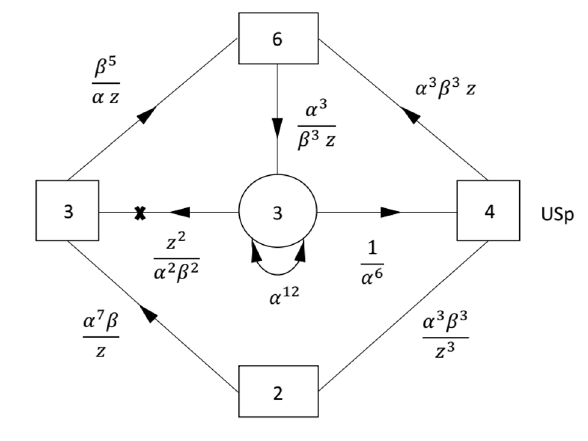
Figure 17 . The tube we get by gluing the tube in figure 16(a) with the one in figure 16(b). As usual, we have denoted the charges under the non-R symmetries using